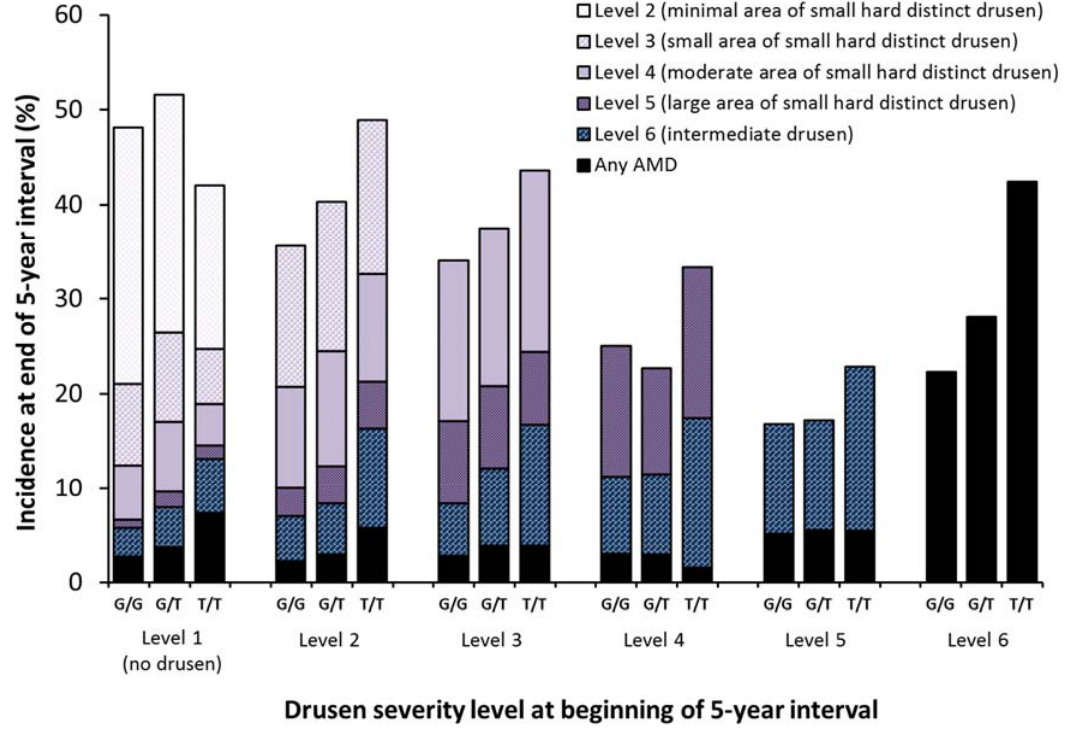
Figure 5. Five-year incidence of increasing area of small hard drusen, intermediate drusen, and any AMD by ARMS2 A69S (rs10490924) genotype and severity level at the beginning of the